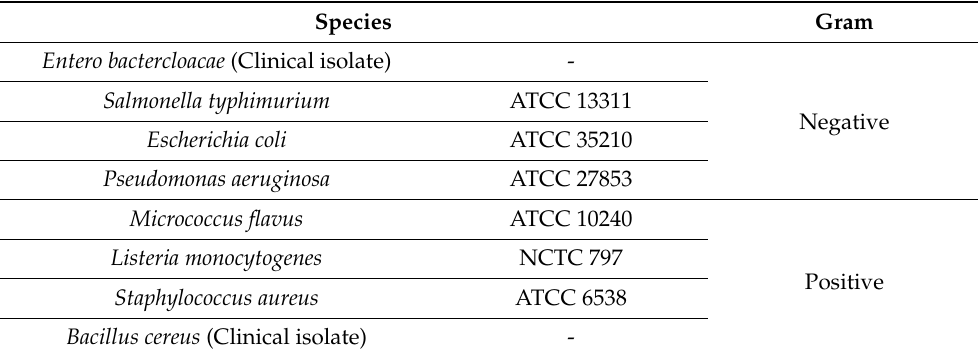
Negative Positive